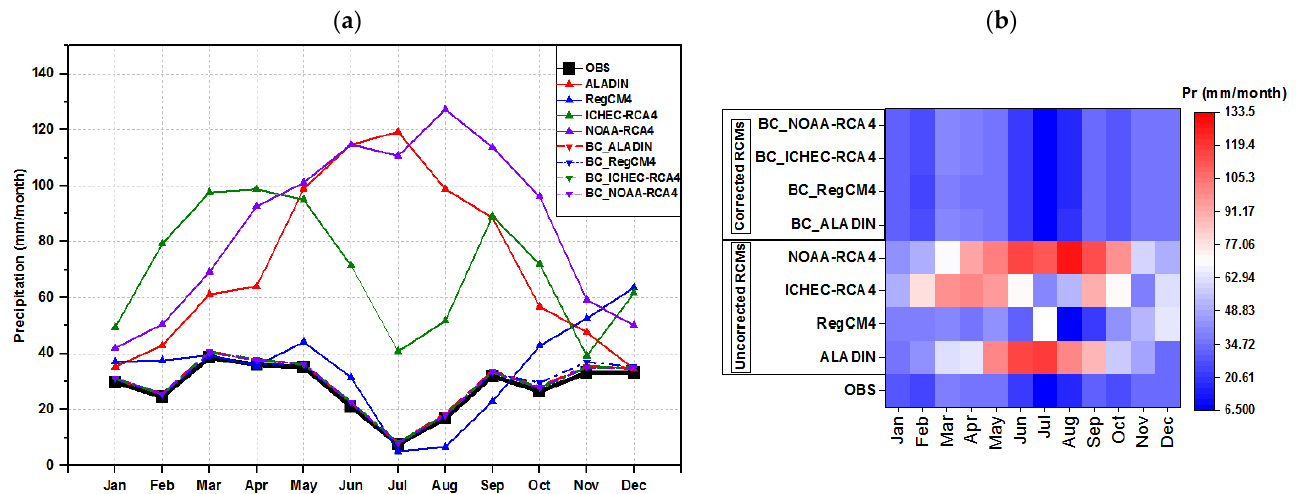
Figure 4. Areal-averaged monthly precipitation for observed, Raw and adjusted RCMs across the Wadi Chemora Basin region for the period (1970 – 2005). ( a ) Line graph plot; ( b ) heatmap plot.